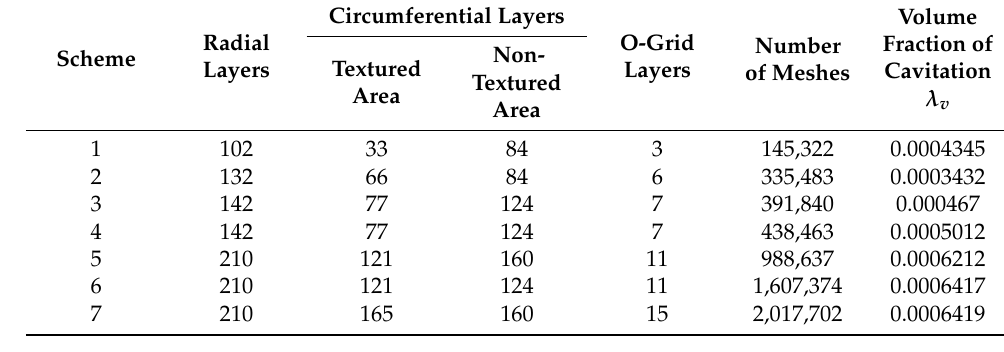
Table 2. Independence test of mesh